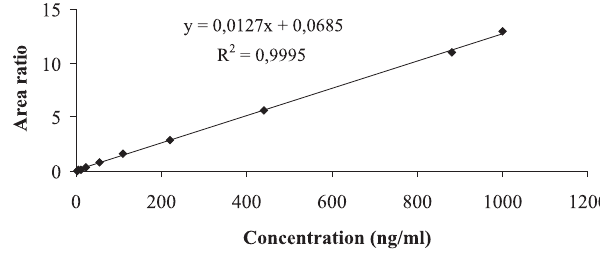
Figure 2 - Linearity of morphine concentration in plasma (0.5-1000 ng/mL)